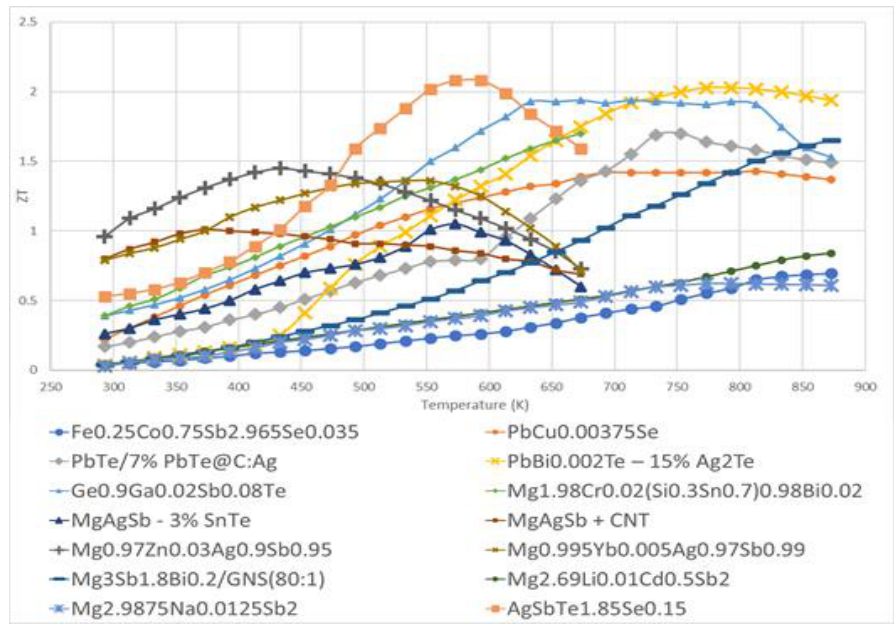
Figure 9. The thermoelectric materials enhanced through a range of nanotechnology techniques across a mid-temperature range: AgSbTe 1.85 Se 0.15 gives the greatest ZT value of 2.08 over this range, achieved by simultaneously increasing the power factor and decreasing the thermal